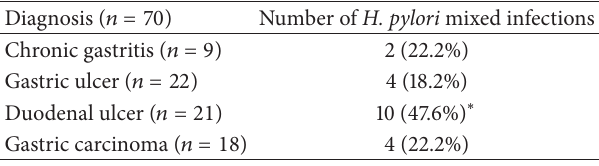
Table 3: Prevalence of mixed H. pylori infections in patients with chronic gastritis, gastric ulcer, duodenal ulcer, and gastric